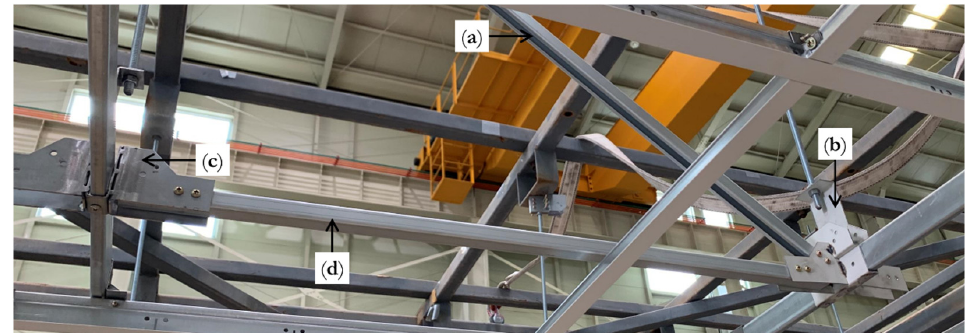
Figure 7. Installation of brace reinforcement member in SDB-3: ( a ) rigid brace member, ( b ) hanger for 2-direction brace, ( c ) hanger for reinforcement member, ( d ) reinforcement member.